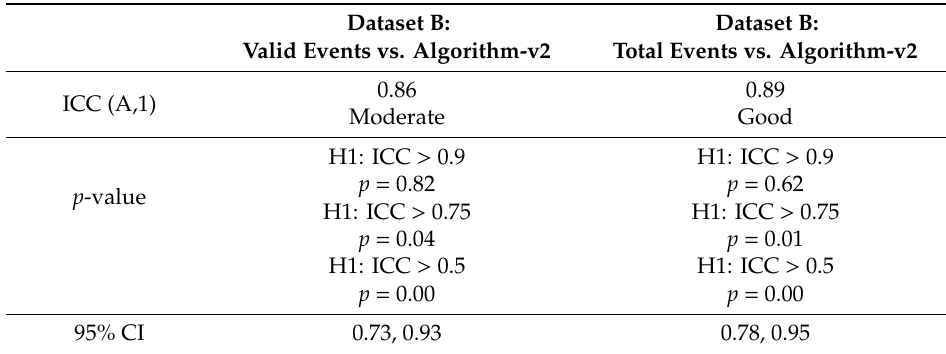
Table 3. IRR results for Algorithm-v2. It performed well on data from older adults (second column). Not omitting unsuccessful sit-to-stand transitions did not improve Algorithm-v2 performance (third column).